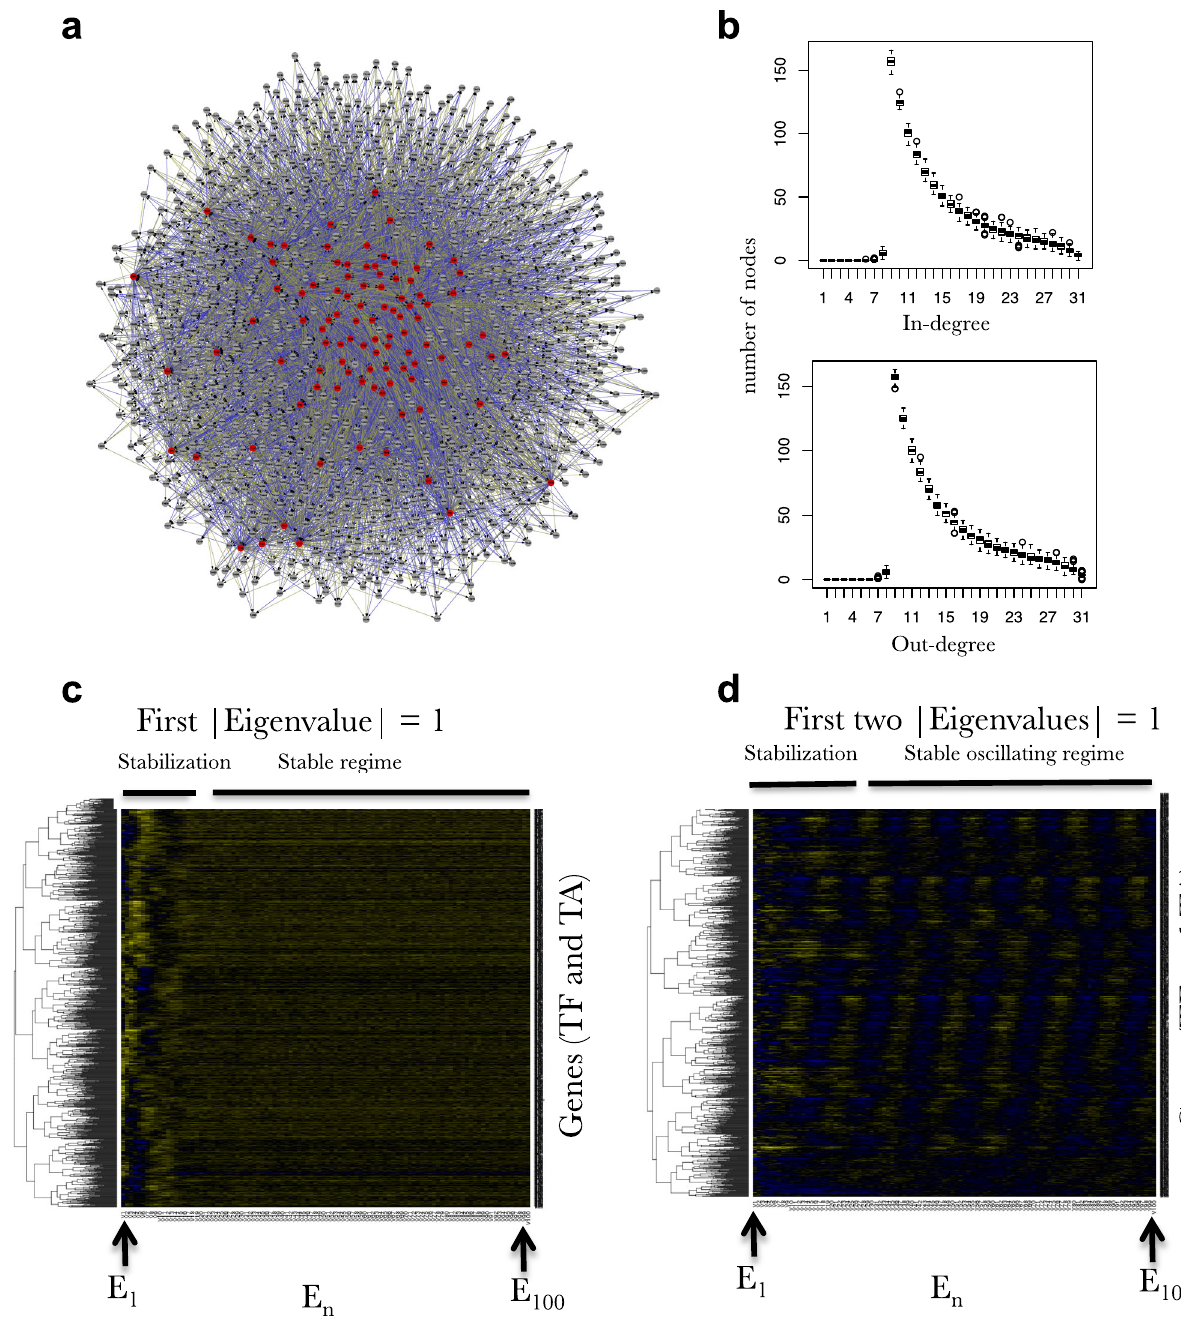
Fig. 2 Example of a FRANK outputs (100 TF, 1000 TA). a Cytoscape view of a FRANK simulated network having scale free properties. The nodes represent the genes the edges represent the connections in the network ( Blue : repressive, Yellow : inductive). b Example of in-degree and out- degree distributions harboring scale-free properties of 100 simulated networks containing 1000 TF and 1000 TA each. c Heatmap representations of simulated gene expression from a network (100 TF, 1000 TA) having one Eigen value forced to be equal to 1, d Heatmap representations of simulated gene expression from a network (100 TF, 1000 TA) having two Eigen values equal to 1. This heatmap exactly corresponds to the expression of the network depicted in ( a Four benchmarks methods for gene network inference and learning: reasons for selecting SVM . The LASSO is a penalized mean square program with l1 penalty (see the historical reference). 34